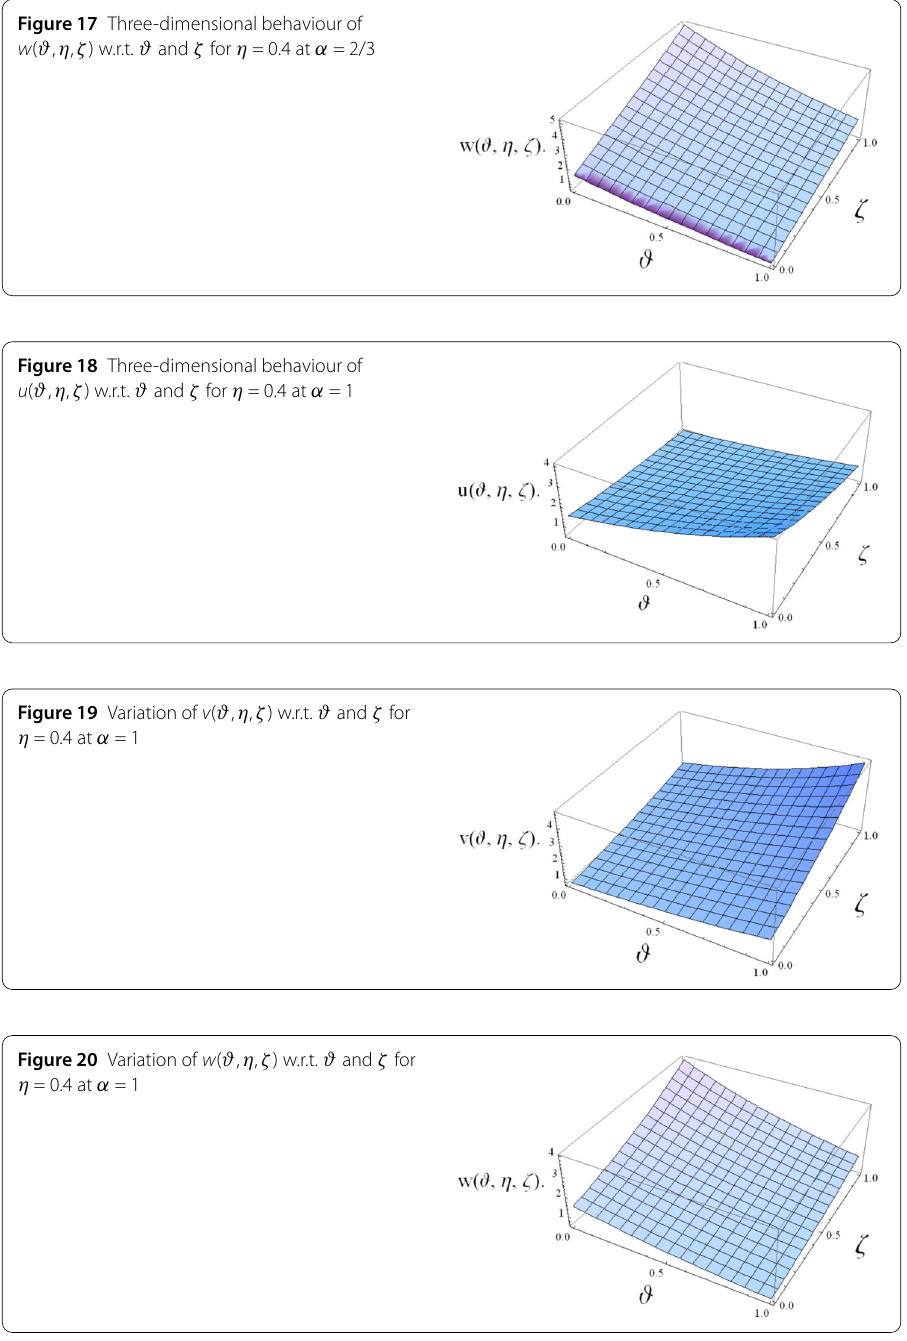
has a clear advantage over other techniques in the sense that it yields approximate solu- tions of the problems by utilizing the contextual choice of an initial guess